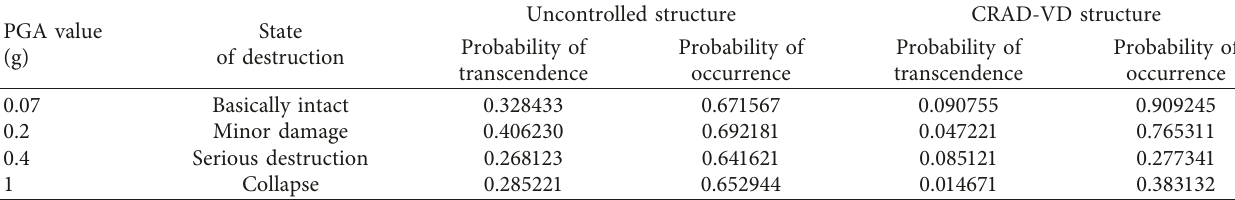
Table 7: Probability of basic integrity of the uncontrolled structure and additional CRAD-VD structure in different earthquakes. PGA value